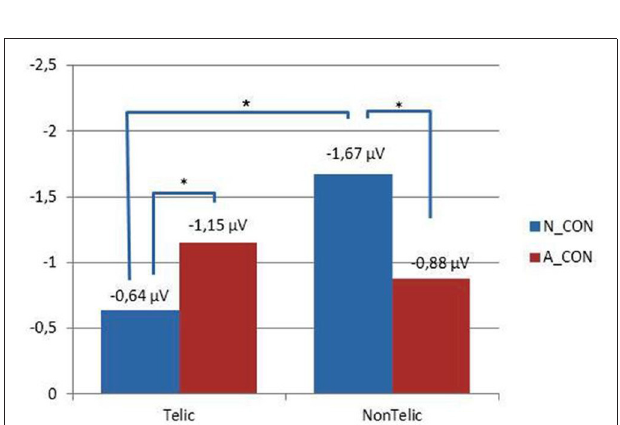
FIGURE 5 | Crossing over regarding the N400 component. Relative to the neutral context, the ad-hoc affordance-inducing context significantly enhances the N400 component for Telic noun-verb combinations whereas it significantly reduces the N400 component for NonTelic noun-verb